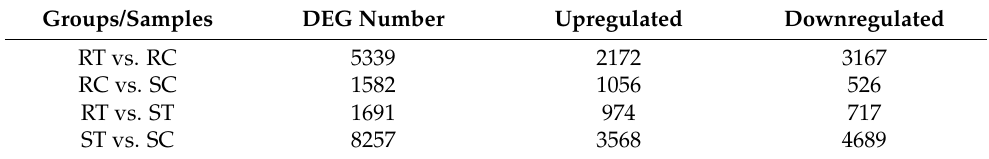
Table 4. The number of differentially expressed genes (DEGs) between different treatment groups.